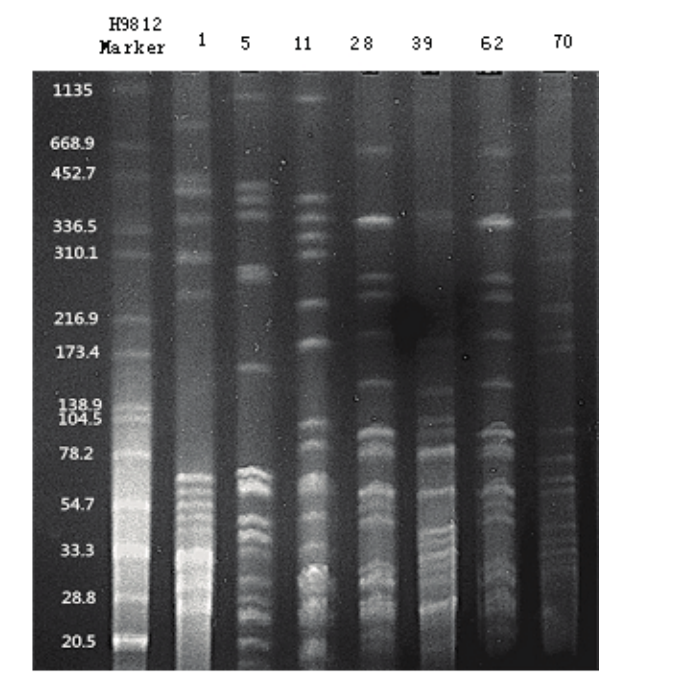
Figure 2. PFGE of 29 smqnr gene-positive S. maltophilia clinical